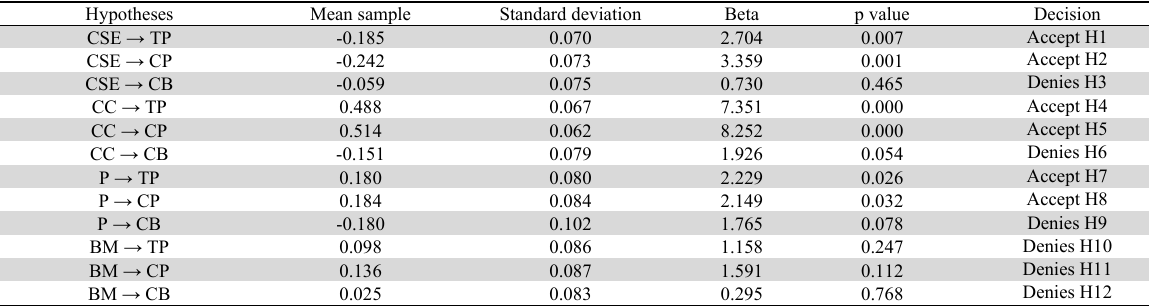
Results of the model structure